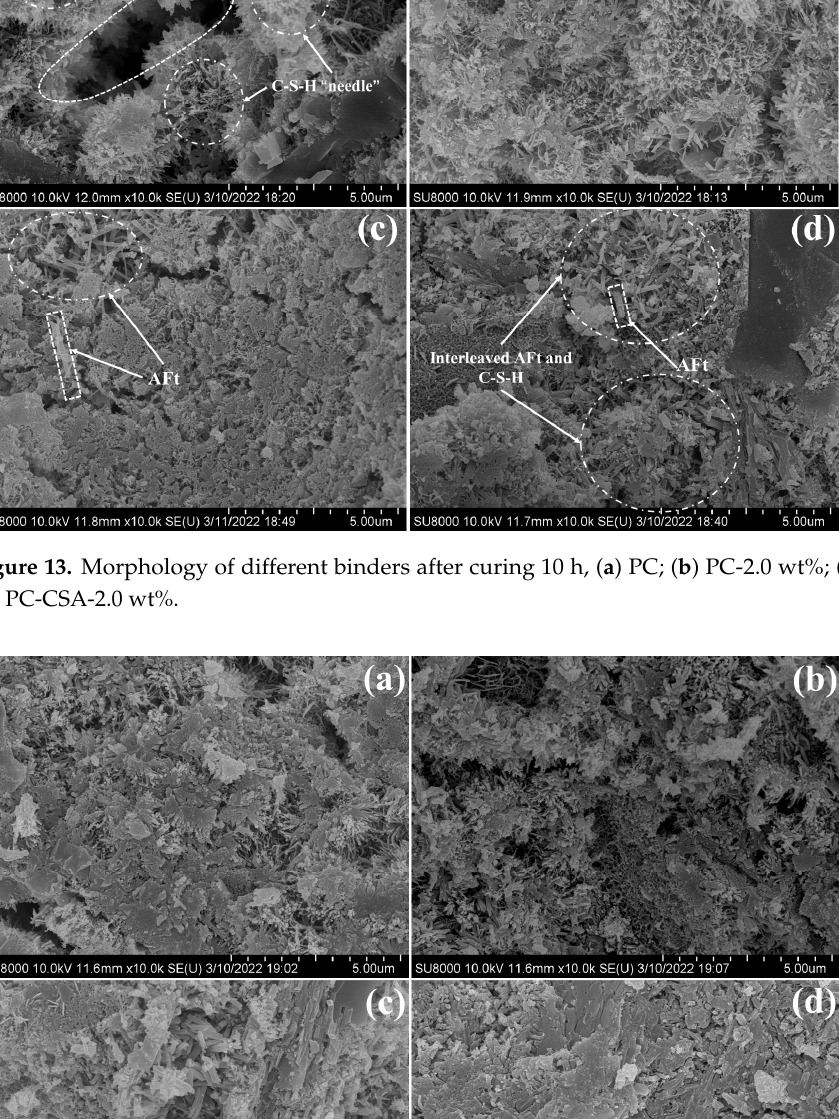
Figure 14. Morphology of different binders after curing 3 d, ( a ) PC; ( b ) PC-2.0 wt%; ( c ) PC-CSA; ( d ) PC-CSA-2.0 wt%.